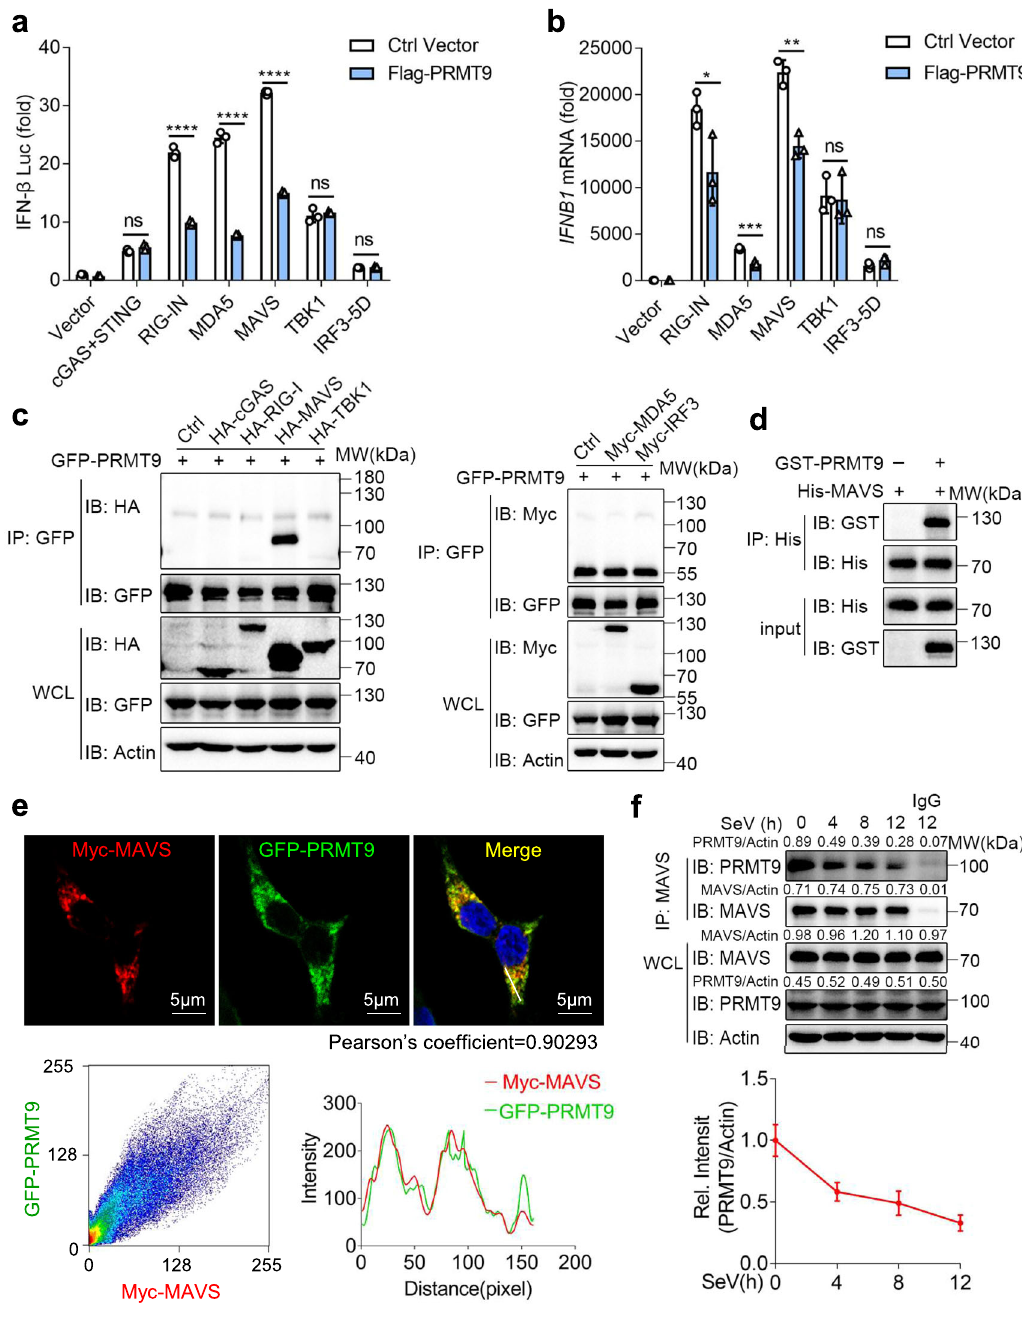
Fig. 5 | PRMT9 targets MAVS. a Luciferase (Lucif) activity assays of IFN- β reporter in HEK293T cells transfected with expression plasmids for cGAS- STING, RIG-IN, MDA5, MAVS, TBK1, or IRF3-5D along with Flag-PRMT9 or con- trolvector(Ctrl)for24h(mean± SD,two-tailedstudent ’ s t -testFlag-PRMT9vs. Ctrl Vector, ns =0.0959, **** p < 0.0001, **** p < 0.0001, **** p <0.0001, ns= 0.5018, ns = 0.5552 in sequence; n = 3 independent experiments). b qRT-PCR analysis of IFNB1 mRNA in HEK293T cells transfected with the indicated adap- tors with Flag-PRMT9 or control vector (mean ±SD, two-tailed student ’ s t -test Flag-PRMT9 vs. Ctrl Vector, * p =0.0446, *** p = 0.0008, ** p = 0.0018, ns= 0.8231, ns =0.1474 in sequence; n =3 independent experiments). a , b Results are presented relative to those of untreated cells transfected with a Vector plasmid. c Co-IP analysis of the interaction between PRMT9 and adaptors in HEK293T cells cotransfected with GFP-PRMT9 and HA-cGAS, HA-RIG-I, HA-